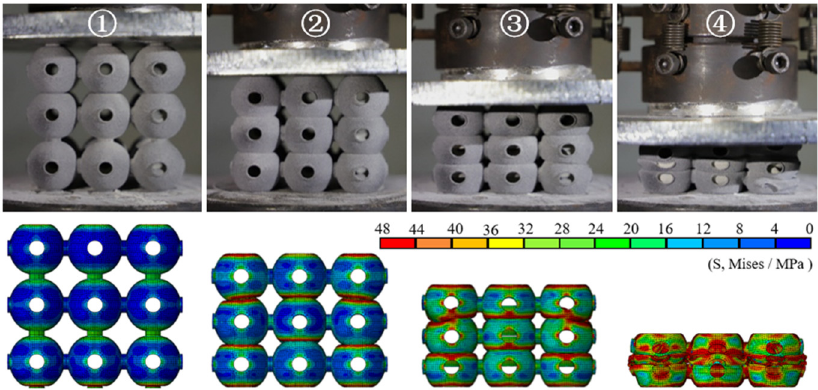
Figure 5. Deformed SC structures at different stages.